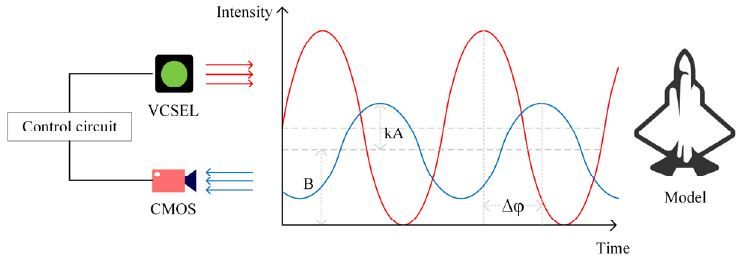
Figure 10. Working principle diagram of ToF camera based on continuous wave modulation.